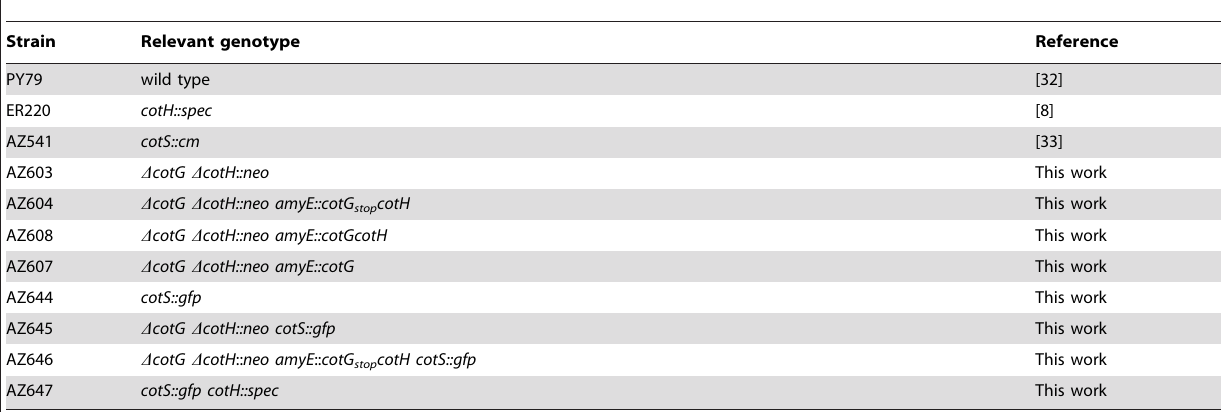
Table 1. Bacillus subtilis strains used in this